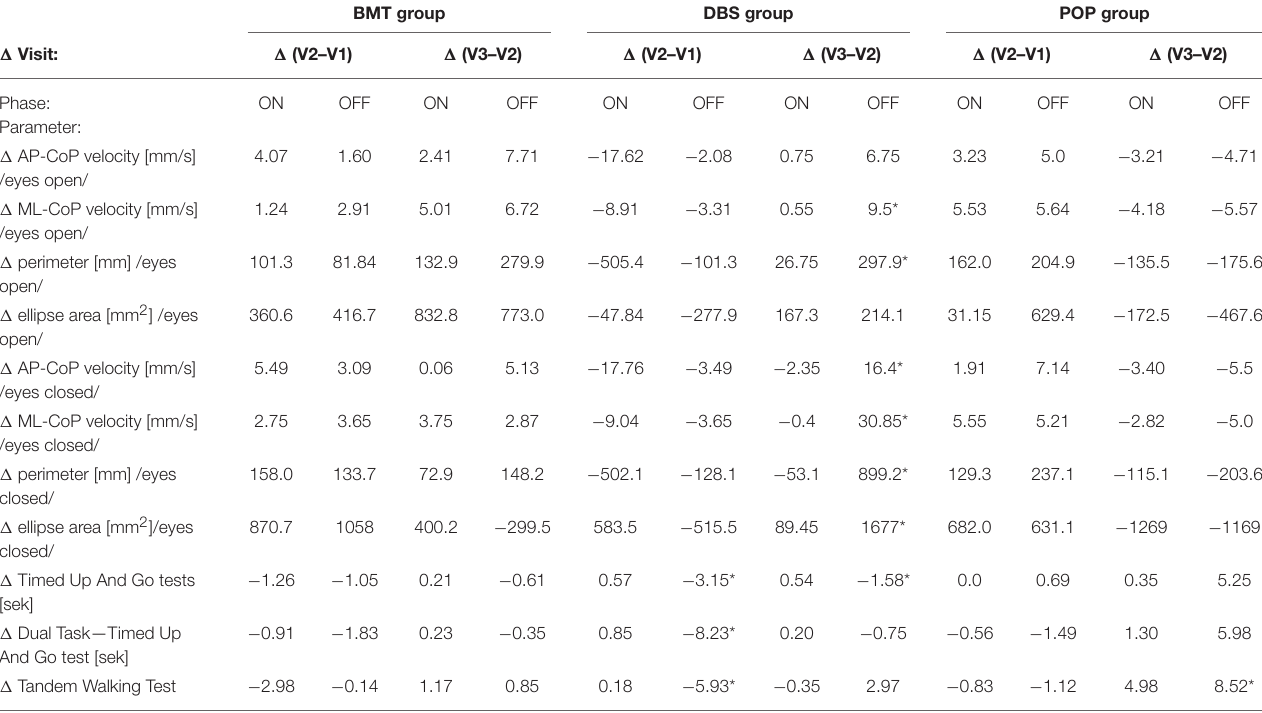
TABLE 2 | Posturography and clinical balance tests’ parameters in study groups: 1 = inter-visit differences. BMT group DBS group POP